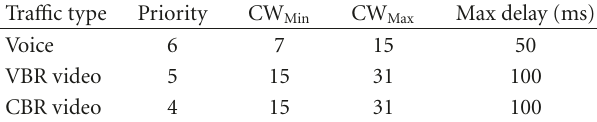
Table 3: Tra ffi c specification.